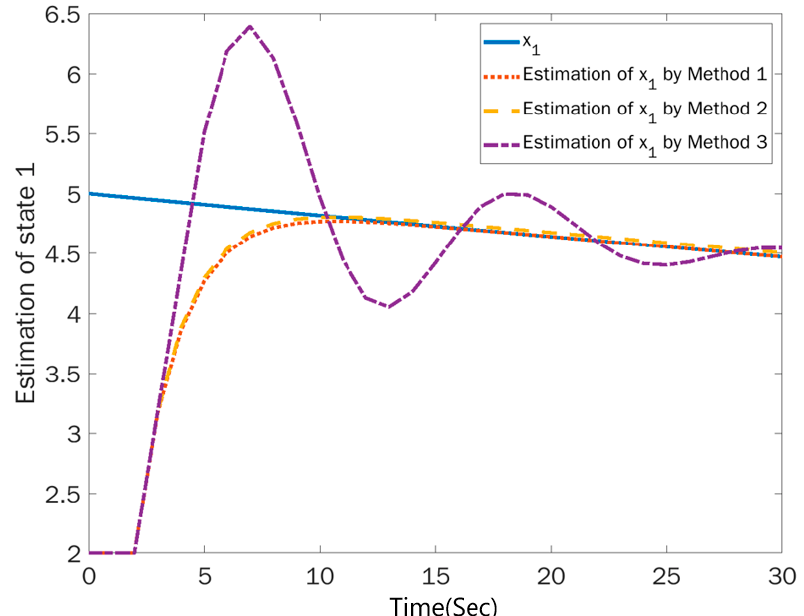
Figure 3. The state 1 estimation results of the three introduced observers.